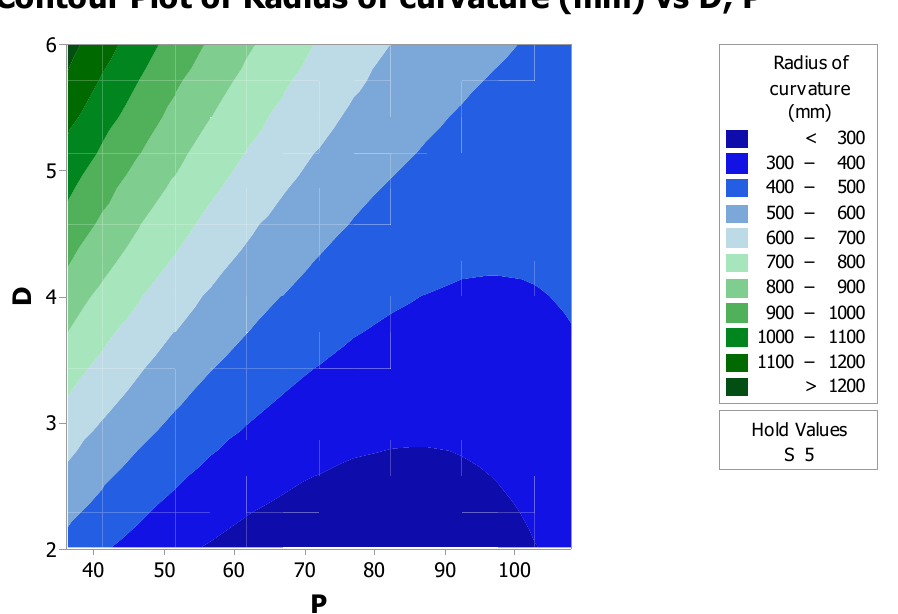
Figure 4. The interaction between laser power and distance between irradiation lines on the radius of curvature.